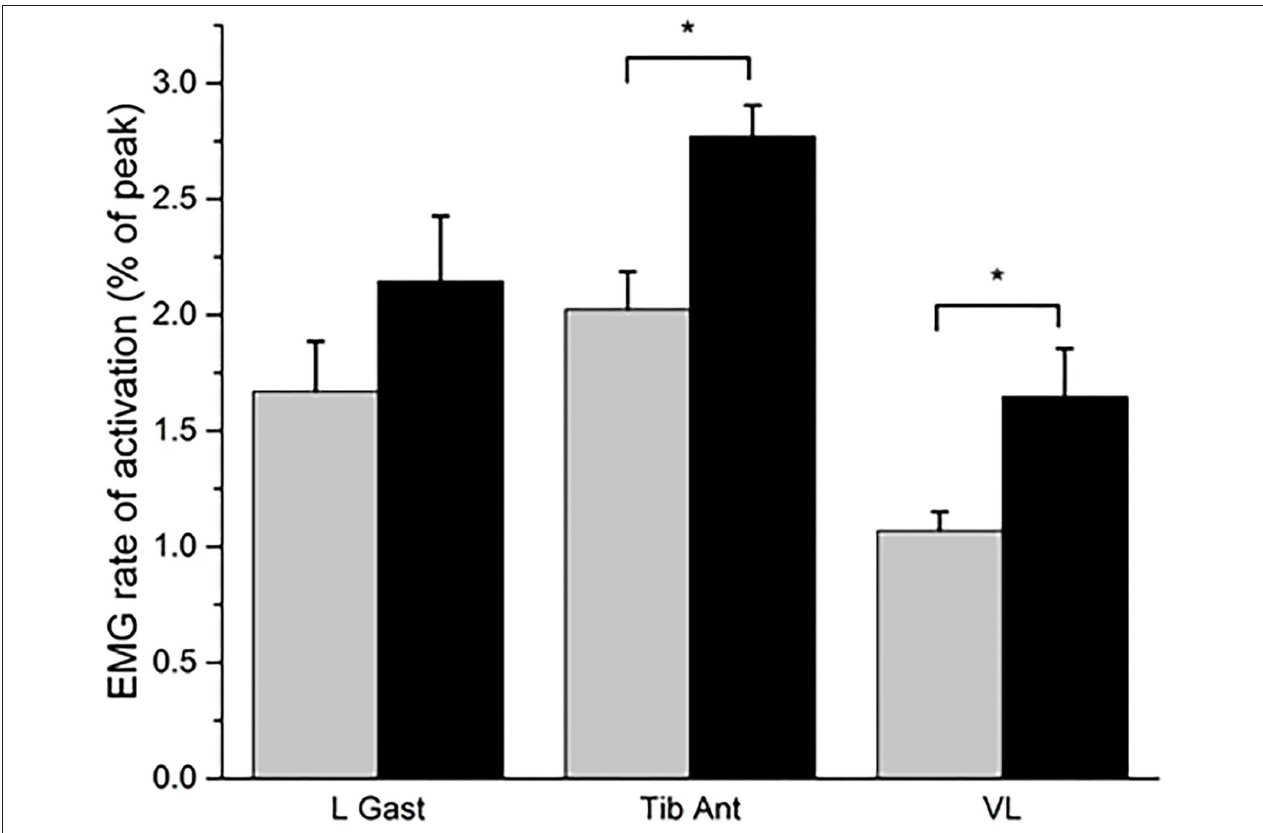
FIGURE 1 | The rate of activation of the lateral gastrocnemius (L Gast), tibialis Anterior (Tib Ant), and vastus lateralis (VL) muscles at baseline (gray bar) and post-training (black bar). Expressed as the mean and standard error. * P < 0.05 for the Wilcoxon signed-rank